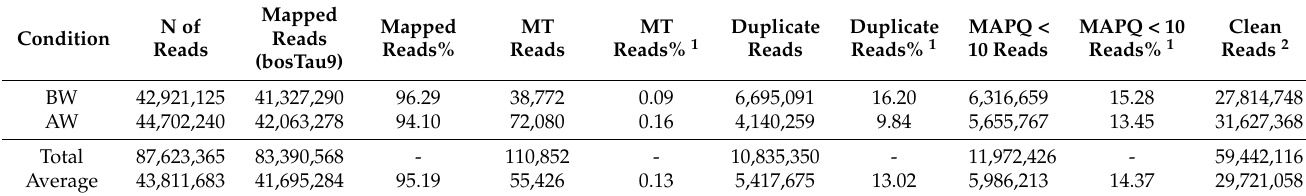
Table 1. CTCF ChIP sequence read statistics showing the number of reads, number and percentages of reads mapped, mitochondrial reads, duplicate reads and reads with mapping quality < 10, and the number of clean reads used for peak calling.